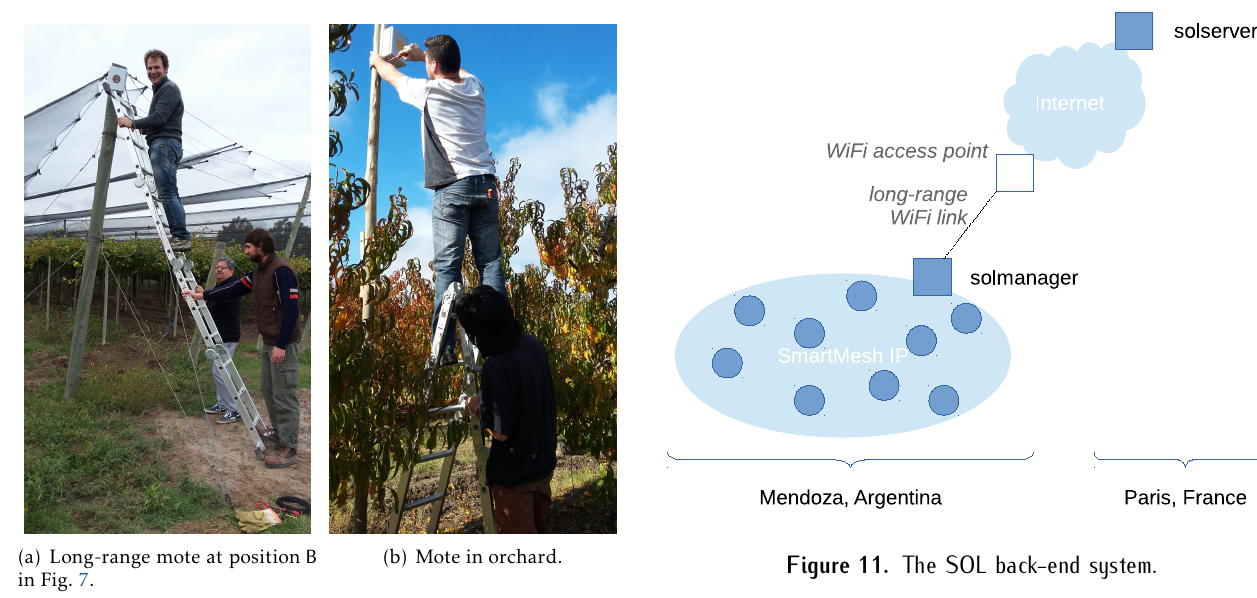
Figure 10. Members of the team deploying motes.